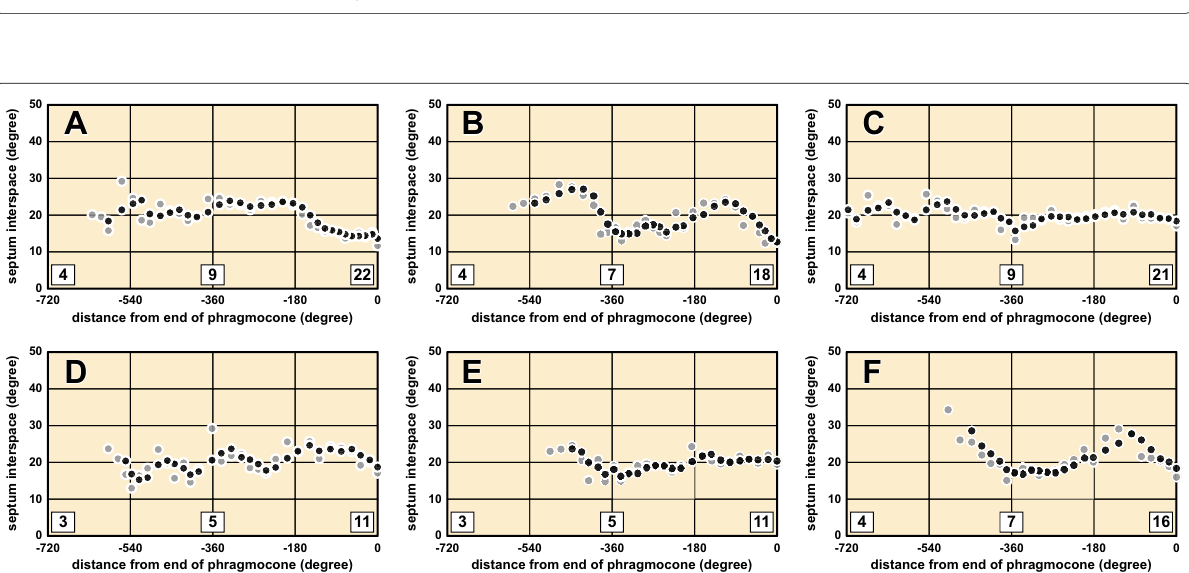
Fig. 16 Ontogenetic trajectories of septal distances in six specimens of Taouzites taouzensis (Bensaïd, 1974) from Hassi Nebech, specimens MB.C.30285.1-6. Respective phragmocone diameters (in mm) in the bottom